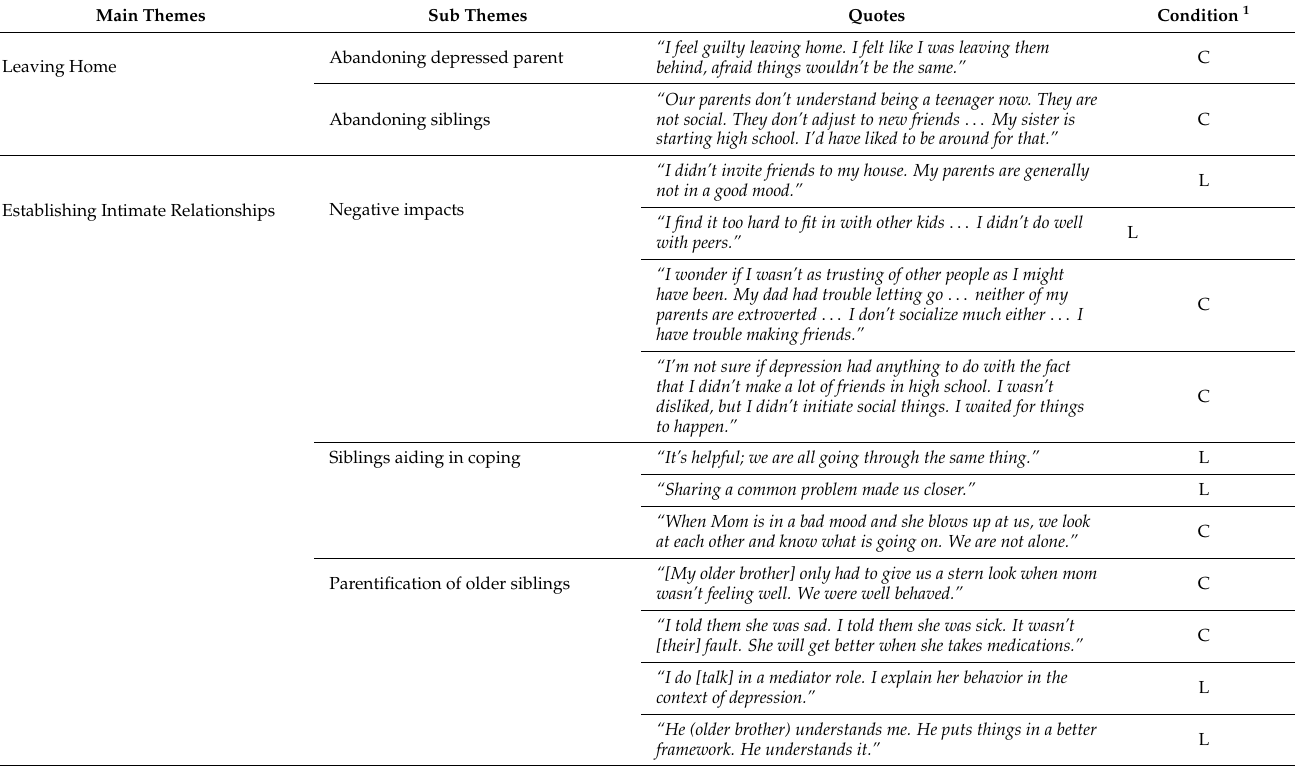
Table 7. Direct quotes from qualitative interviews with participating young adults relating to the themes addressed in the